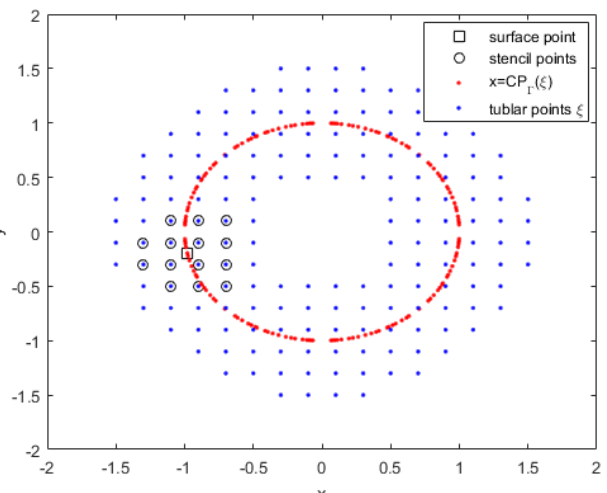
Figure 1. A scheme of the closest points (red dots) to the tubular points in the computational domain (blue dots) on the surface and m = 14 point stencil (circled blue dots) for a surface point (squared red